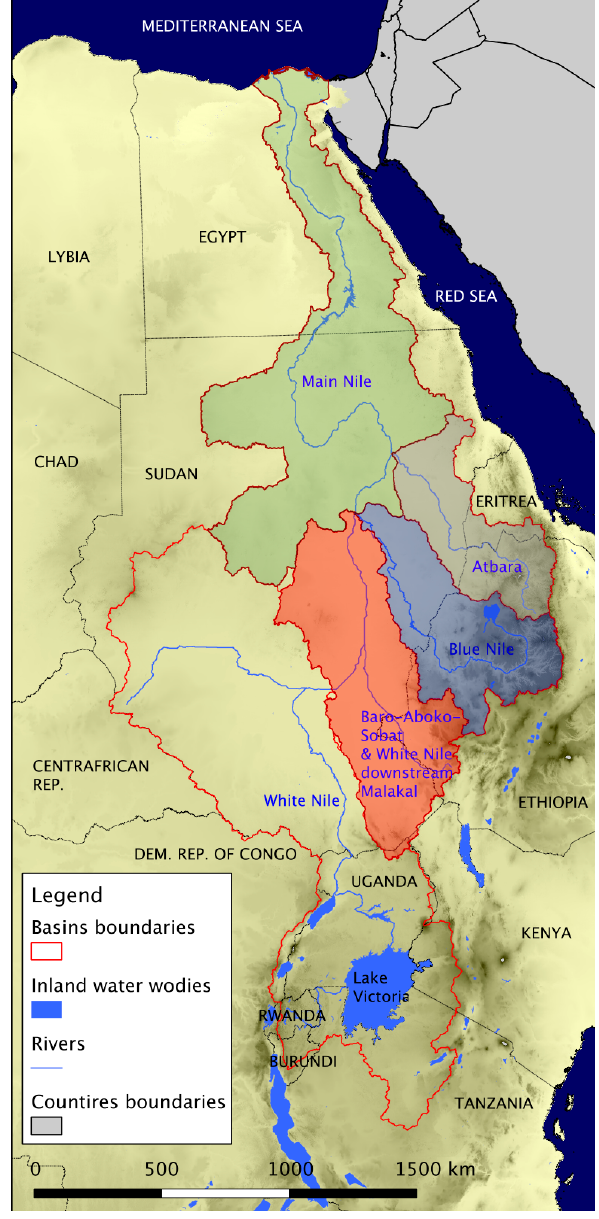
Figure 3. The Eastern Nile River